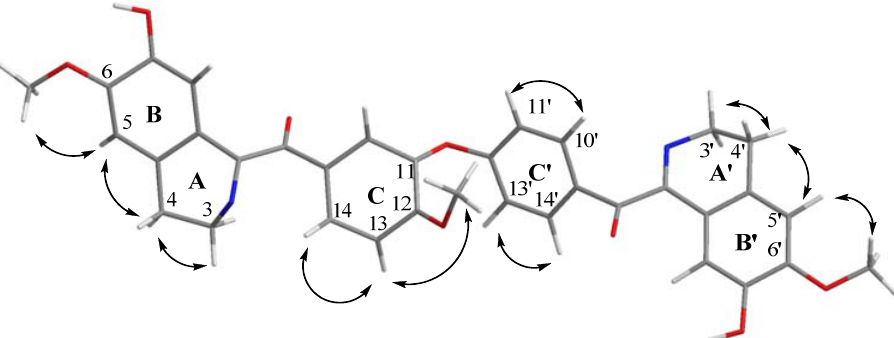
Figure 3. Selected NOESY correlations of lancifoliaine ( 1 ).